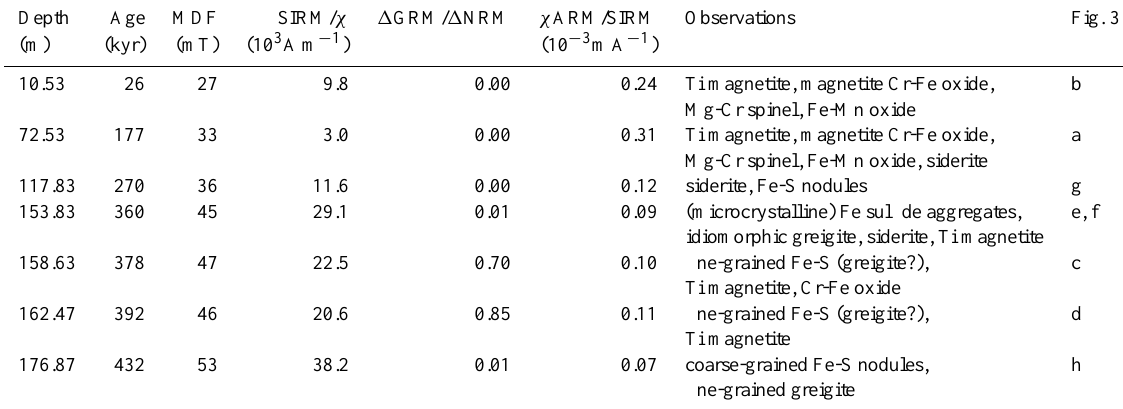
Table 1. Magnetic properties of samples used for scanning electron